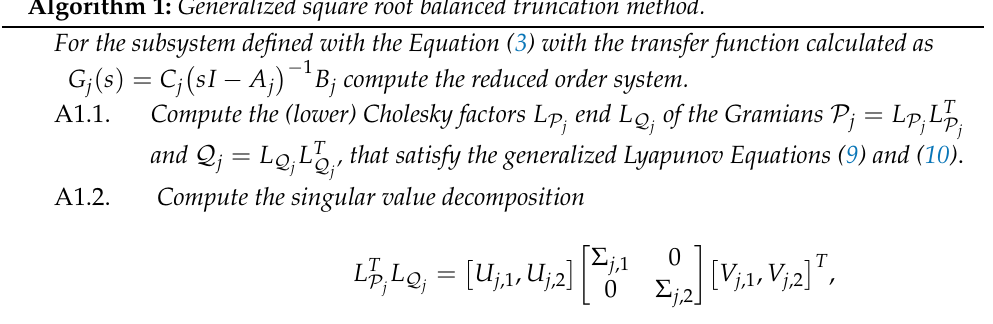
Algorithm 1: Generalized square root balanced truncation